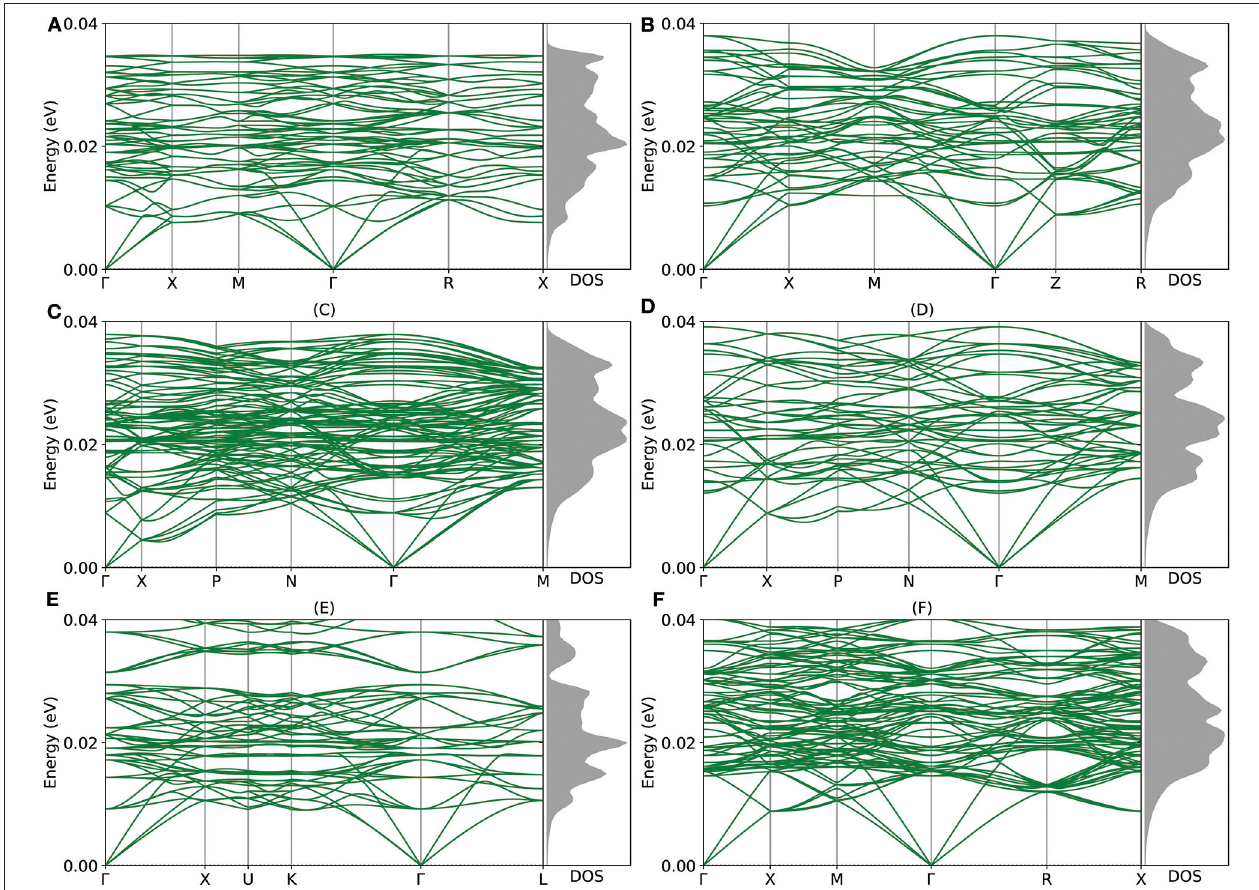
FIGURE 4 | (A–F) The phonon structures of Mg 12 Al 8 , Mg 7 Al 9 , Mg 14 Al 18 , Mg 6 Al 10 , Mg 8 Al 16 , and Mg 5 Al 27 calculated by Deep Potential (DP) model are shown.